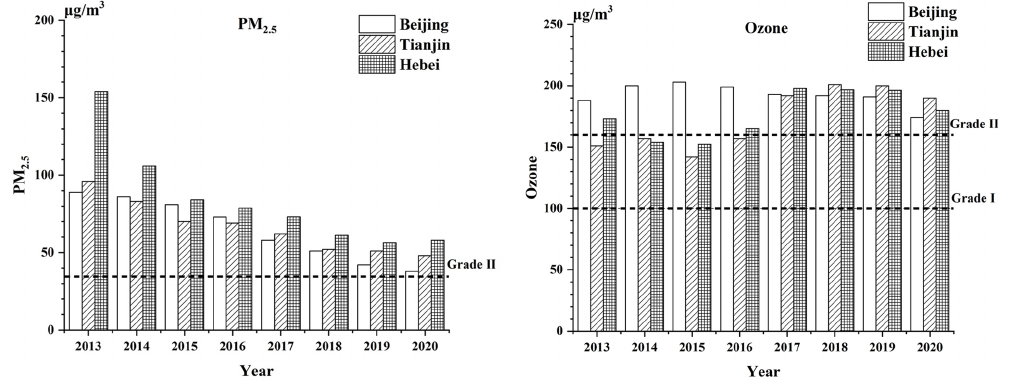
Figure 2. Annual average concentration of PM 2.5 ( left ) and average top consecutive 8 h concentration of ozone ( right ) in the Beijing–Tianjin–Hebei region from 2013 to 2020. The spatial distributions of PM 2.5 and ozone in the BTH region in 2018 are shown in Figure 3. More serious PM 2.5 pollution was observed in the southern areas of the BTH region. The distribution of PM 2.5 concentration was consistent with that of a recent study [26]. Using the national monitoring data, this study presented the spatial distribution of PM 2.5 concentration in China in 2015 (Figure 1), which shows the most severe PM 2.5 pollu- tion was observed in the Center-East region. In this region, the PM 2.5 pollution was higher in Henan, Shanxi, Shandong, and Hebei Provinces than in Beijing–Tianjin City. Due to the industrial and energy structures, the emissions of different air pollutants vary very much among cities. Figure S2 shows the amount of PM 2.5 emissions in the Center-East region in China [32]. Beijing and Tianjin are the largest metropolitan cities, where heavy industries are no more the major sectors of the economy. The PM 2.5 emissions were lower in both cities than in other cities. Tangshan City of Hebei Province, the largest heavy industrial city in the region, has the country’s largest iron and steel production capacity and the largest PM 2.5 emissions (208,463 t/y), which were significantly higher than the emissions of other cities in the region [32]. Cangzhou City of Hebei Province also has high PM 2.5 emissions of 85,407 t/y [32]. The much larger emissions of major air pollutants in Hebei Province can result in higher PM 2.5 concentrations observed in Hebei Province than in Bei- jing and Tianjin City. A high concentration of ozone was also found in the southern area of Hebei Province and Tianjin City. In contrast, the ozone concentration in downtown Beijing was lower than that in the surrounding suburban areas, such as the western area of Hebei Province and Tianjin City. In the atmosphere, ozone can oxidize NO into NO 2 (O 3 + NO → O 2 + NO 2 ), and the low concentration of ozone in the urban area of Beijing City could result from significant NO emissions from vehicle exhaust.